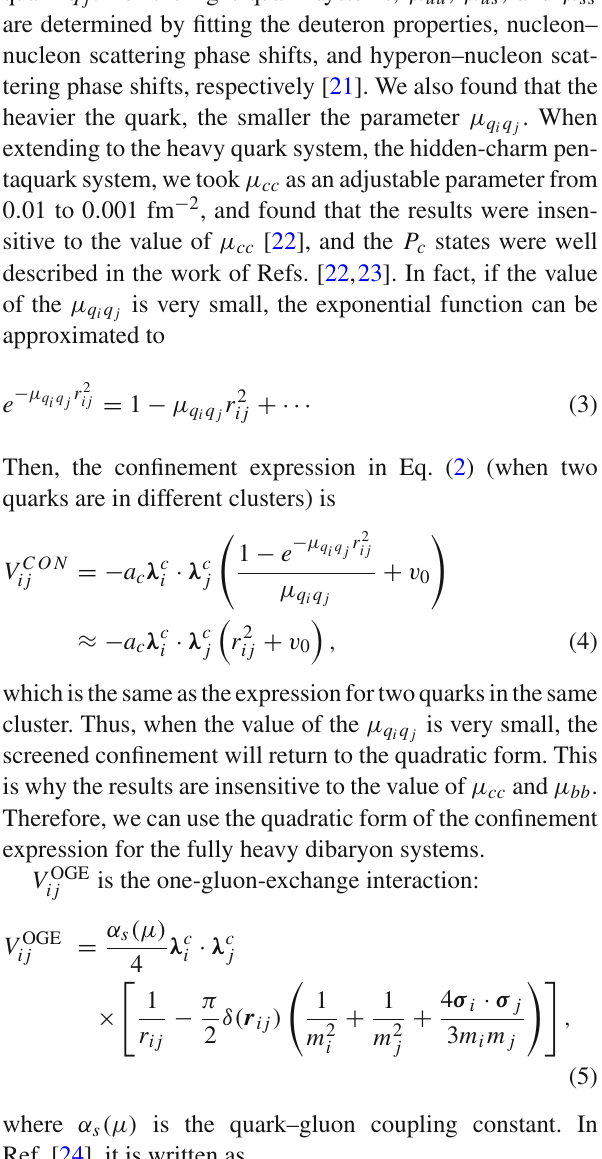
Table 2 The masses (in MeV) of the light, charmed, and bottomed baryons. Experimental values are taken from the Particle Data